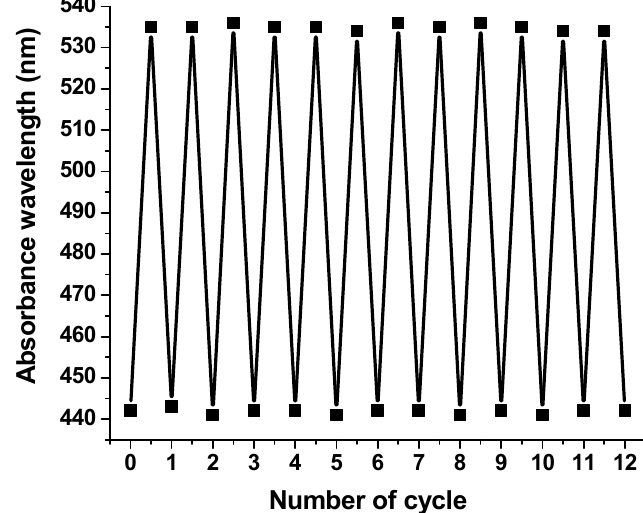
Figure 5. Changes between the absorption maximum wavelengths of UTCFH (0.06 wt%) at 442 and 535 nm at the temperature values of 44 and 63 °C, respectively; pH value was adjusted to ~6.65.